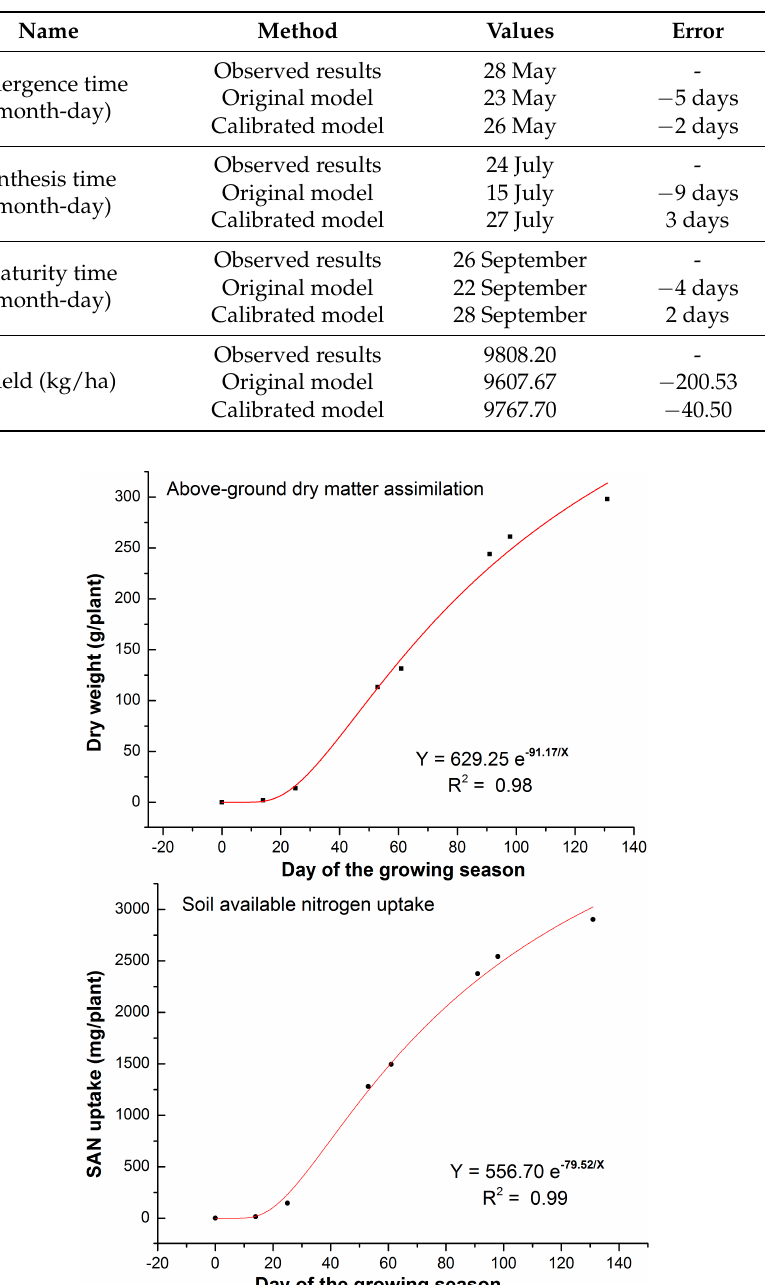
Table 4. Crop growth parameter simulation accuracy of calibrated WOFOST model.